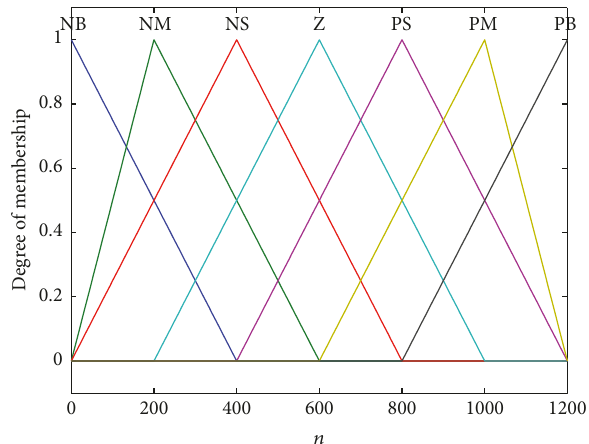
Figure 8: Speed membership function curve.